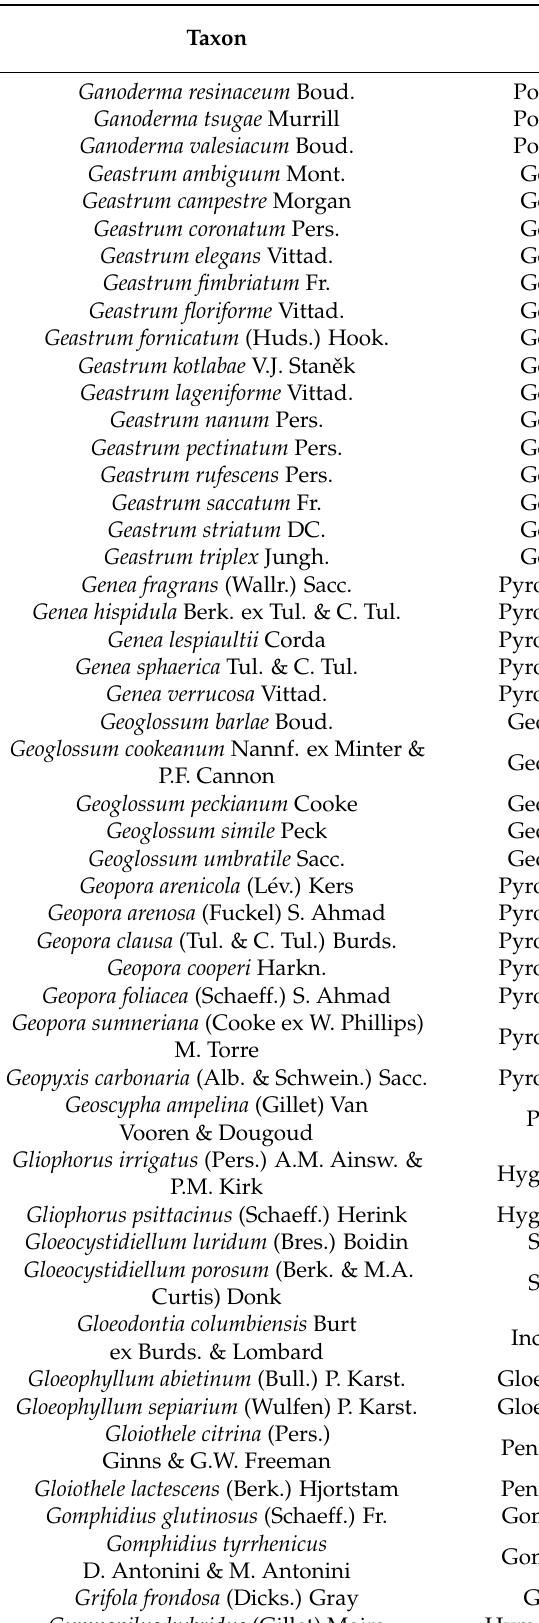
Grifola frondosa (Dicks.)